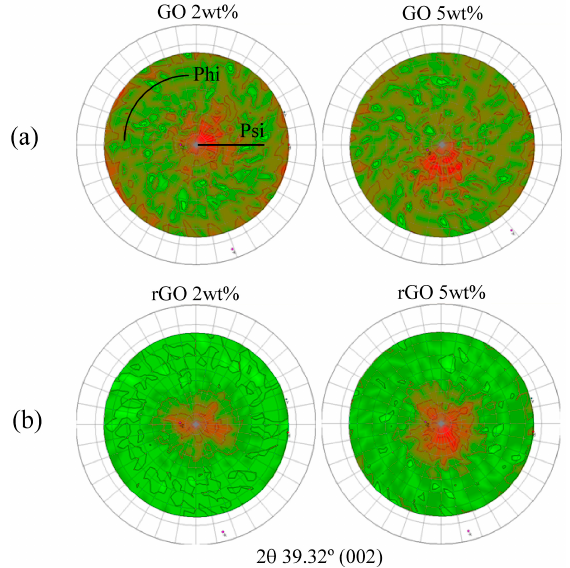
Figure 8. Pole figures of the composites with 2 and 5 wt % of: ( a ) GO and ( b ) rGO in the perpendicular plane.